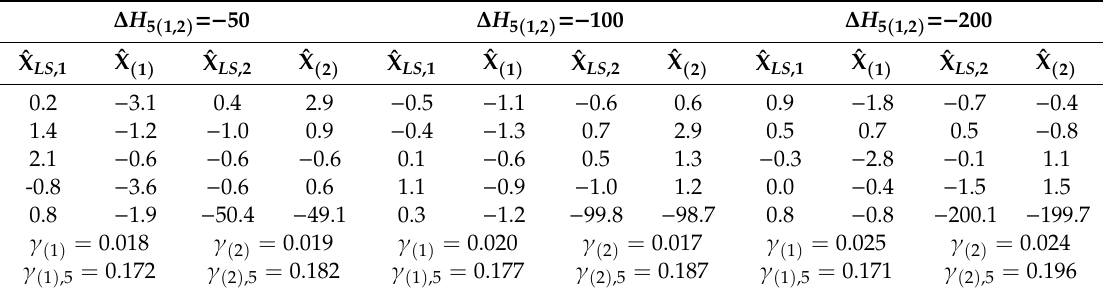
Table 1. The Monte Carlo estimates of the point heights and success rates for one unstable